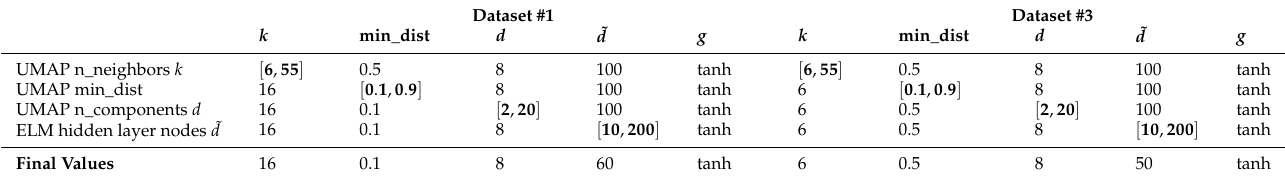
Table 7. One-dimensional sequential GridSearch of the UMAP and ELM hyperparameters (the other parameters are set to their default: Metric ( d ) is set to the Euclidean, n_epochs is set to none, and the spread is set to 1) for datasets #1 and #3. The range for the one-dimensional searches is highlighted in bold. Dataset